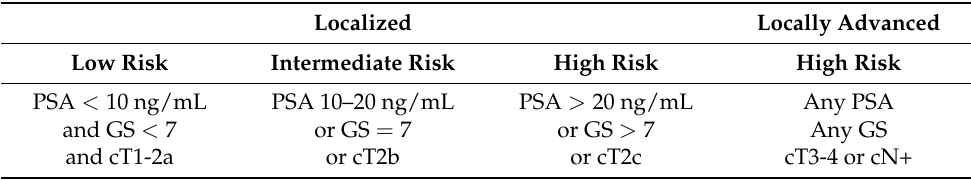
Table 1. Risk groups for biochemical recurrence of localized and locally advanced prostate cancer as defined by the European Association of